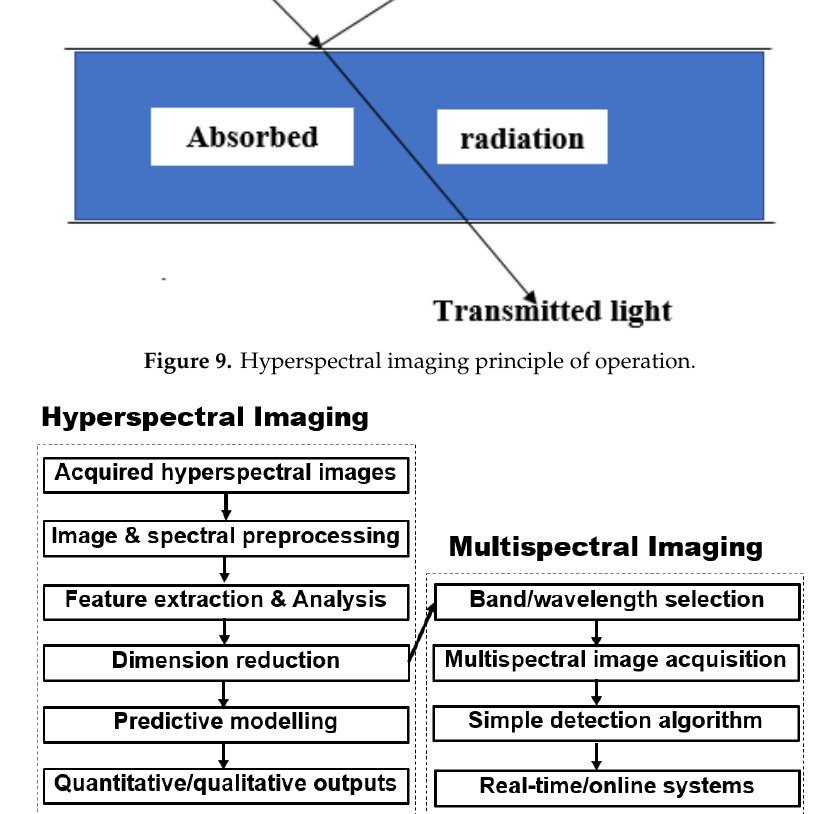
Figure 10. Hyperspectral-Multispectral imaging flow chart